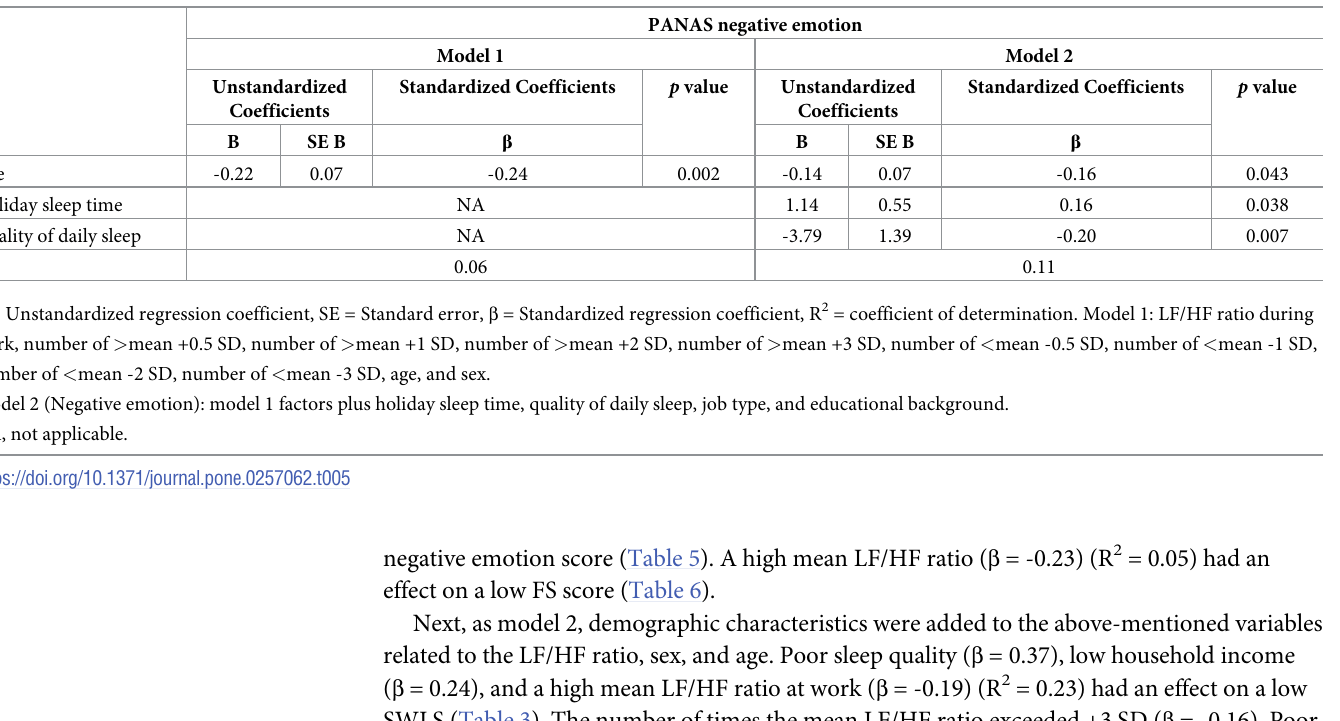
Table 5. Effect of the LF/HF ratio on negative emotion.